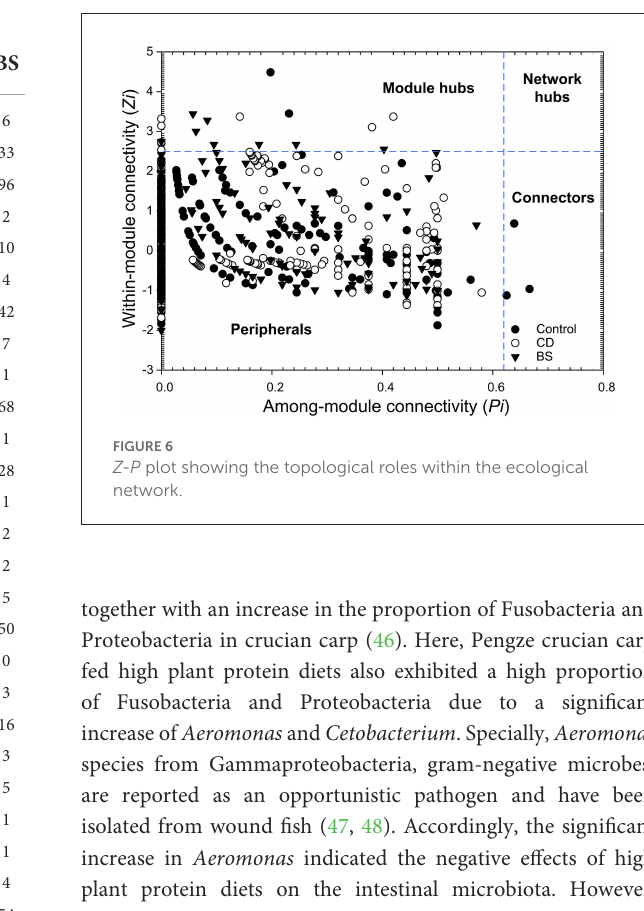
TABLE 2 The composition of the ecological network.